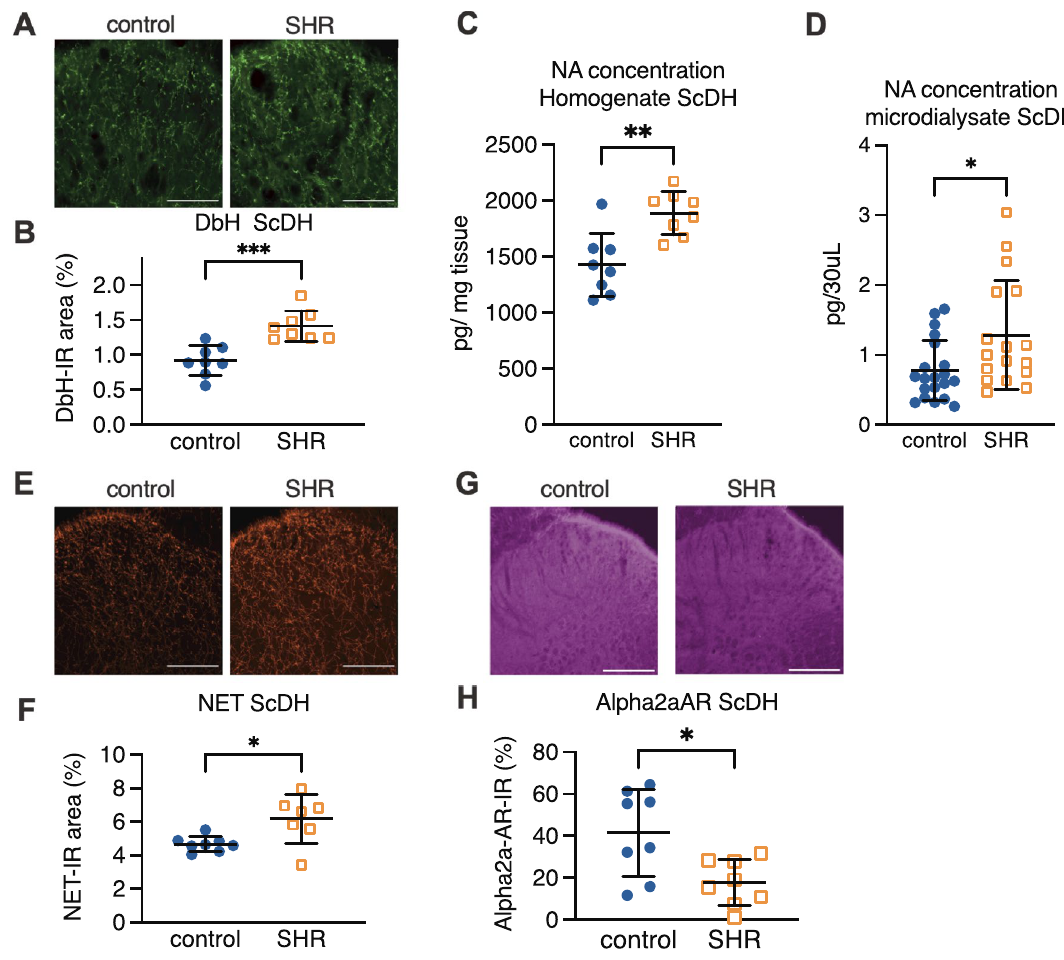
Figure 2. The noradrenergic systems in the spinal dorsal horn. Representative pictures of dopamine- β-hydroxylase (DbH) in the spinal dorsal horn from SHR and control ( A ). The percentage of DbH immunoreactive (IR) area is summarized, and SHR show a larger DbH-IR area than control ( B ). Noradrenaline concentration in the homogenate of the spinal is higher in SHR than in control ( C ). The concentration of spinal extracellular noradrenaline measured by spinal microdialysis prior to capsaicin injection is also higher in SHR than in control ( D ). Representative pictures of the noradrenaline transporter (NET) ( E ). SHR had a significantly greater NET-IR area than control ( F ). Representative pictures of the alpha2-adrenoceptor (Alpha2aAR) ( G ). SHR had a significantly lower Alpha2aAR-IR area ( H ). Mean ± SD, *; p < 0.05, **; p < 0.01, ***; p < 0.001, n = 8 each ( B , C , F , H ), n = 25, 19 ( D ), Scale bar = 200 µm. SHR: spontaneously hypertensive rats (ADHD model), control: Wister Kyoto, ScDH: spinal dorsal